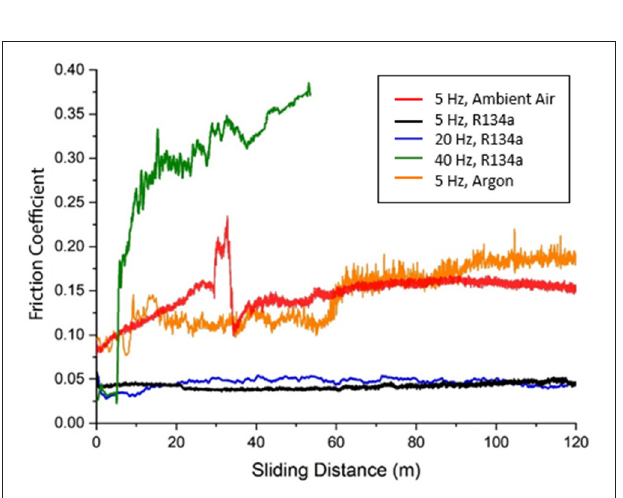
FIGURE 10 | Effect of imposed tribological parameters on friction coefficient evolution.